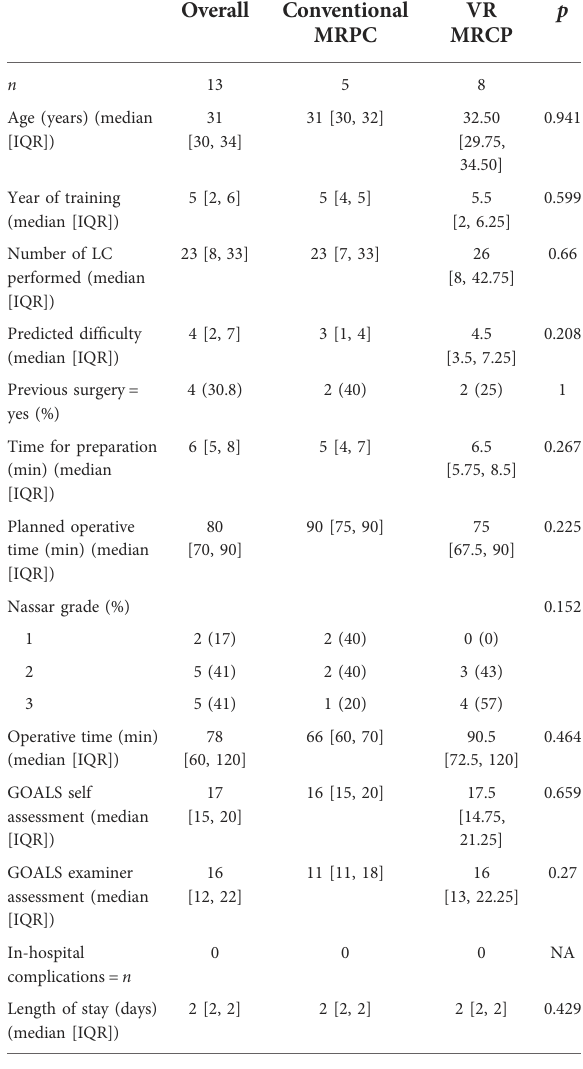
TABLE 2 Results of direct comparison for preoperative preparation of LC with VR MRCP and conventional MRCP.